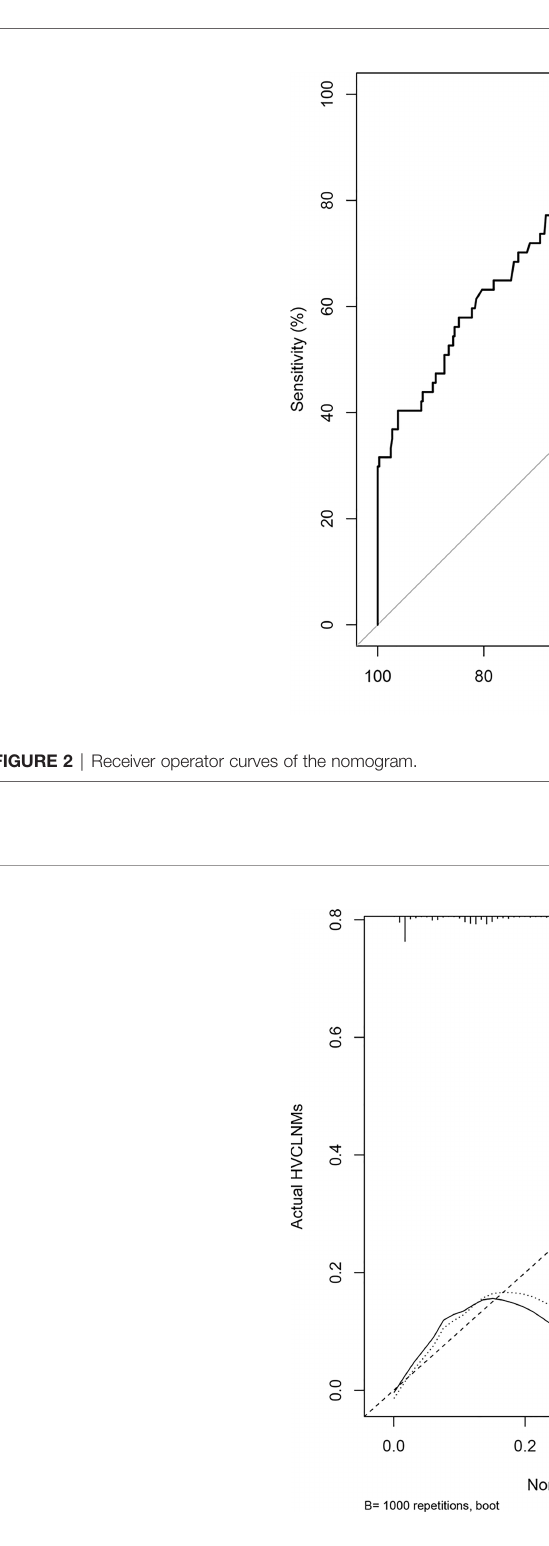
FIGURE 3 | Calibration plot of the nomogram. The x -axis is the nomogram-predicted probability of high-volume central compartment lymph node metastasis (HVCLNMs). The y -axis is the actual probability of HVCLNMs. Dashed line = ideal nomogram; dotted line = apparent predicted accuracy; solid line = calibration estimate from the internally validated model. Perfect prediction would correspond to the dashed